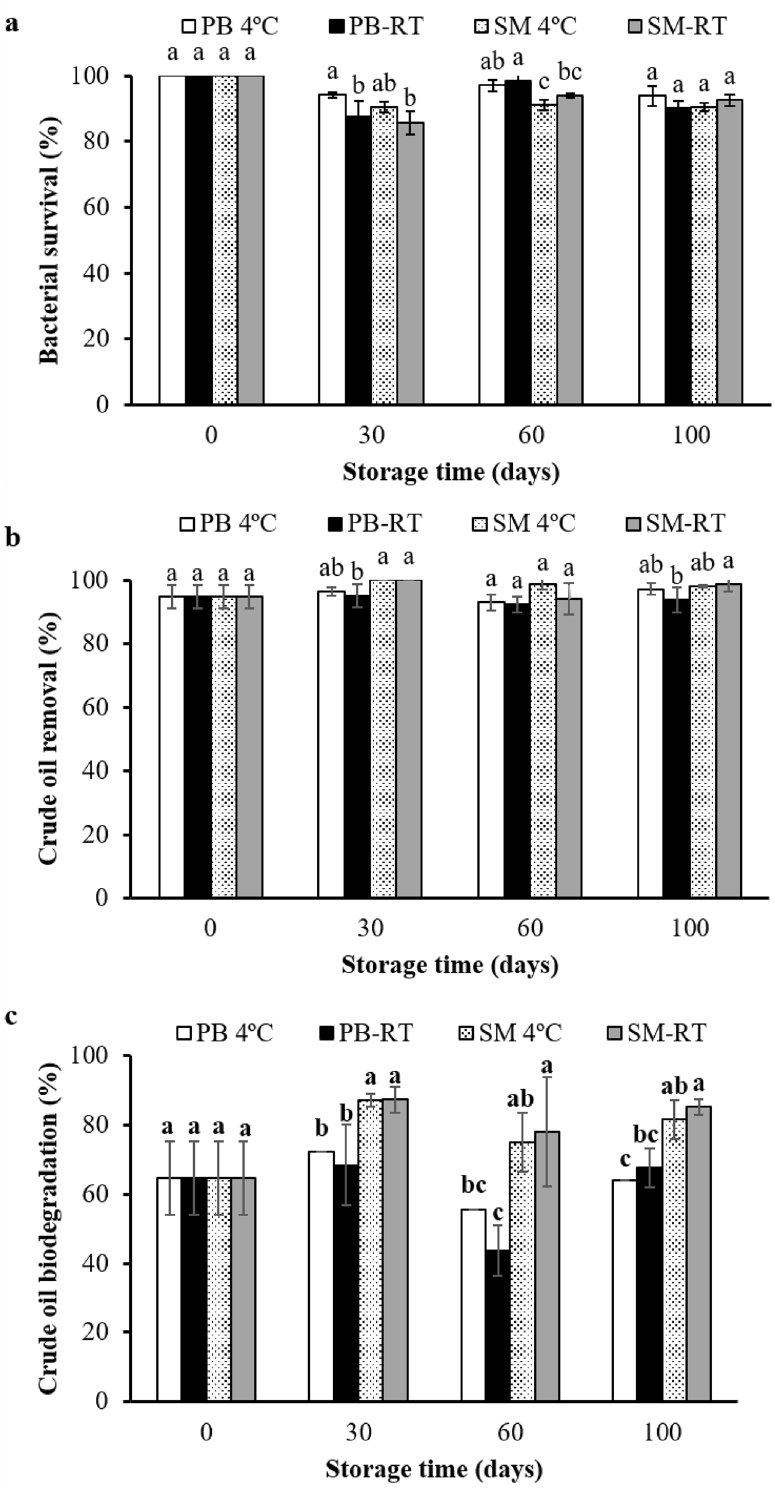
Figure 6. Bacterial survival (%) of immobilized R. ruber S103 after storage for 30, 60 and 100 days in phosphate buffer (pH 6.5) and 10% (w/v) skimmed milk at 4 and room temperature, 30–33 °C ( a ). Crude oil removal from the medium ( b ) and biodegradation of the adsorbed oil by immobilized S103 after storage were carried out in CFMM medium supplemented with 2500 mg L −1 AL crude oil at room temperature with 200 rpm for 3 days. The lowercase letters above the vertical bars represent significant differences in storage conditions ( P <